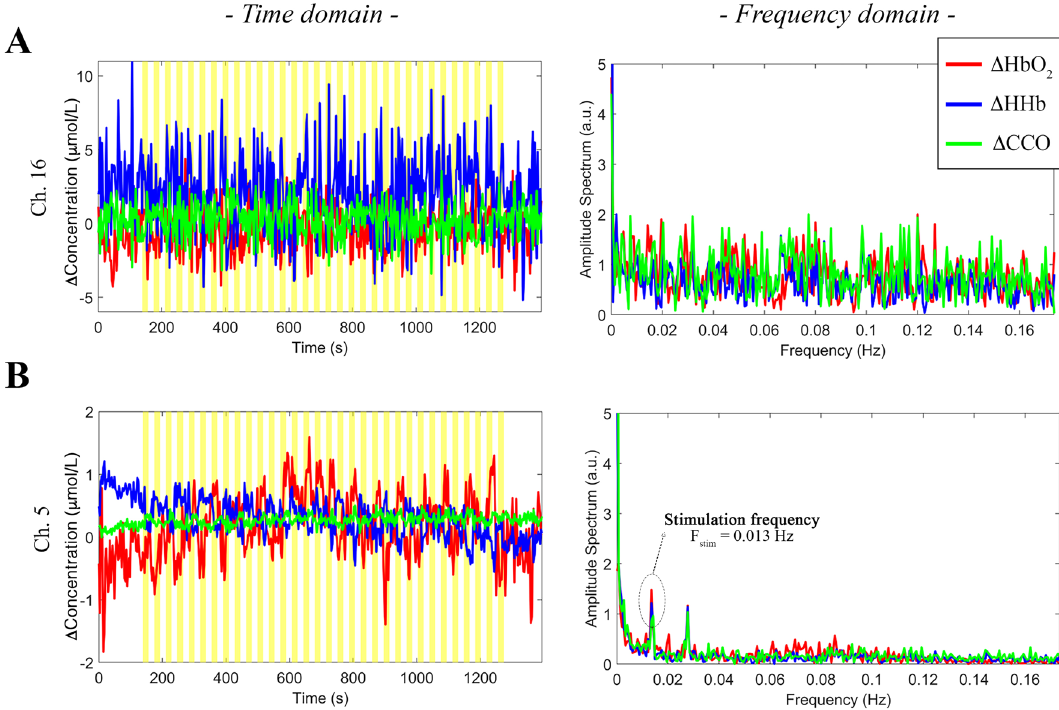
Figure 1. Examples of poor quality ( A ) and good quality ( B ) ΔHbO 2 (red), ΔHHb (blue), and ΔoxCCO (green) signals of two channels from one participant. Data are shown both in the time domain (left) and in the frequency domain (right). Yellow areas mark the visual task